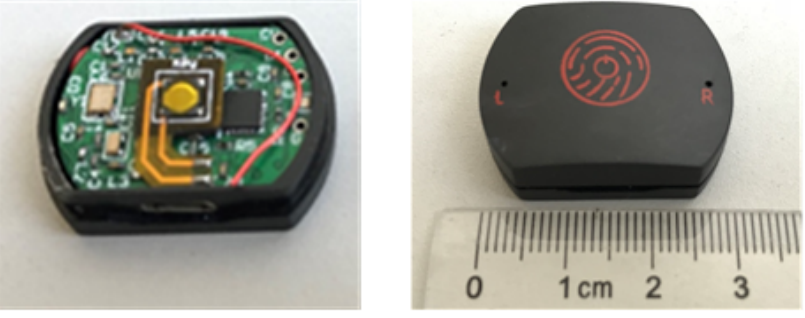
Figure 4. System